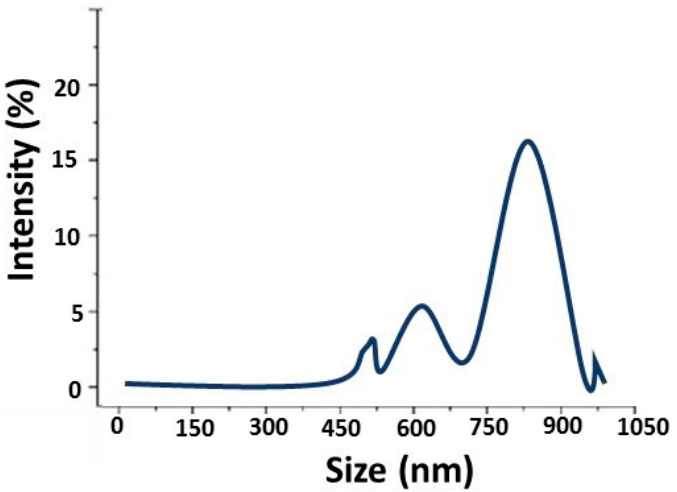
Figure 6. Size distribution of dry milled (60 min) carbon particles.